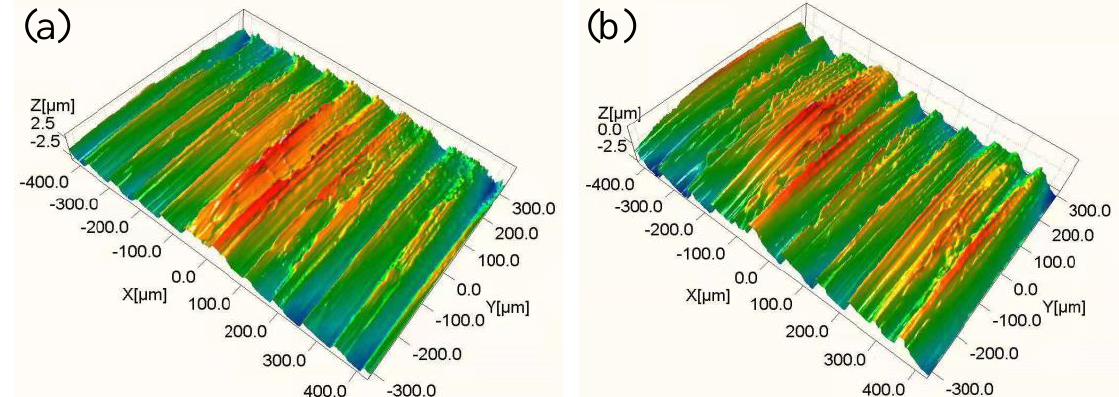
Figure 17. 3D morphologies of samples obtained in ( a ) Experiment #5 and ( b ) Experiment #6.